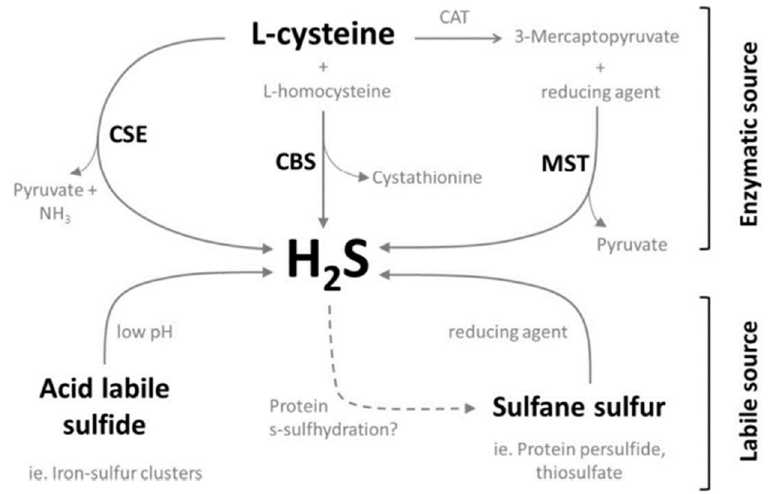
Figure 3. Layout of H 2 S synthesis via enzymatic and labile sources.